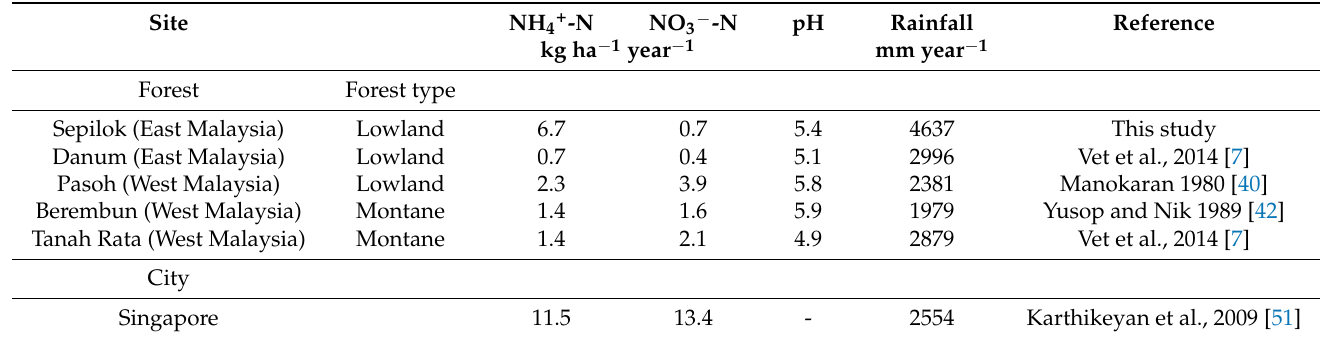
Table 3. Comparison of annual wet inorganic N deposition rates in some Malaysian and Singa- porean